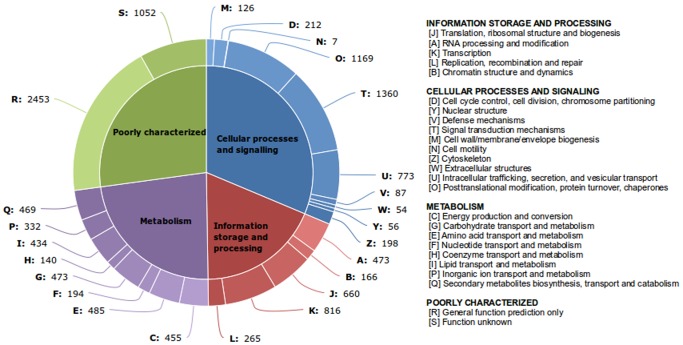
KOG Classification.